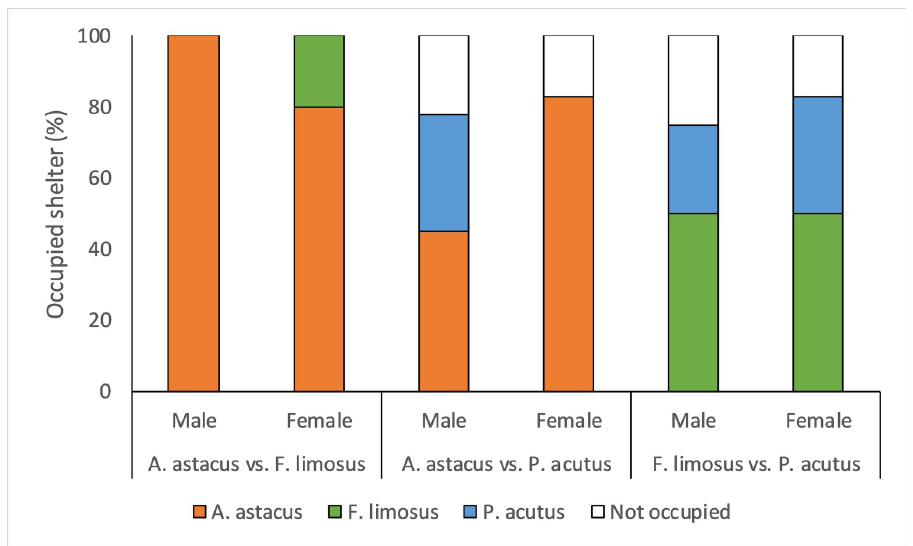
Fig 3. Shelter occupancy by the interacting species in percentages for males and females. Numbers of trialled male and female pairs of each species combination are indicated above the bars.